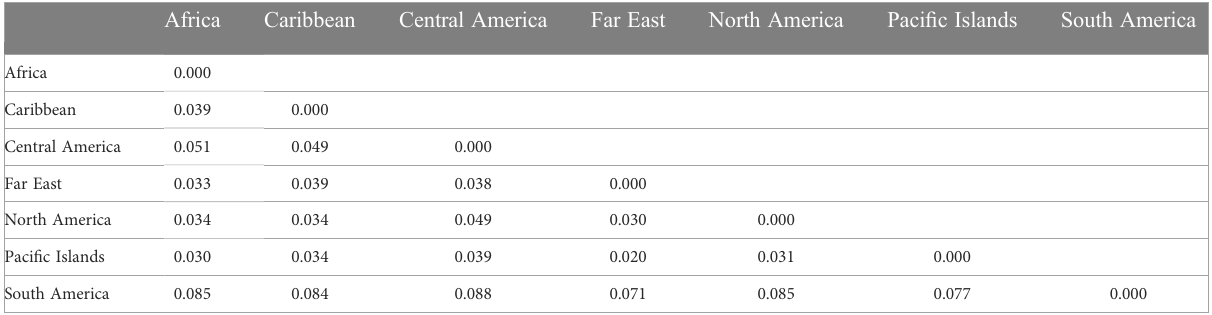
TABLE 2 Pairwise genetic differentiation (F ST Huang unpub estimator – PolyGene V1.4) between geographical regions of 604 sweetpotato ( Ipomoea batatas )